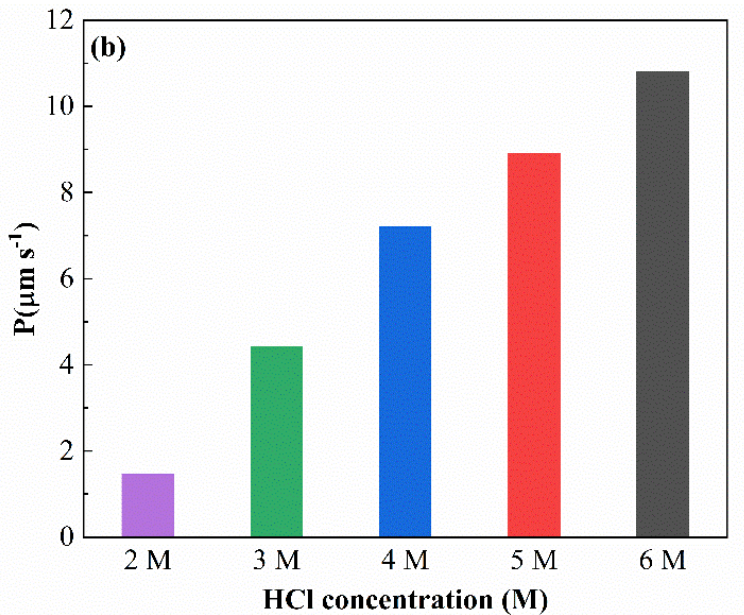
Figure 6. Effect of feed acidity on the transport of Ga(III) by SLMs, ( a ) Extraction percentage, ( b ) permeability coefficient ([Ga(III)] feed = 400 mg/L, Carrier = 0.5 M R 4 NCy, Strip: pH = 1). The influence of the initial Ga(III) concentration in the feed solution on the SLM transport efficiency was also studied, using feed solutions containing different Ga(III) concentrations ranging from 400 mg/L to 1200 mg/L. It can be seen from Figure 7 that the extraction percentage decreased from 97.8% to 75.1% when the Ga(III) concentration increased from 400 mg/L to 1200 mg/L. The permeability coefficient was decreased from 10.8 to 3.03 µ m s − 1 with the increase in the initial concentration. This was probably caused by the membrane saturation in the presence of a high concentration of metal ion, which lowers the available carriers for the interaction with Ga(III). Therefore, a feed solution containing 400 mg/L Ga(III) was selected for optimization of other experimental parameters.